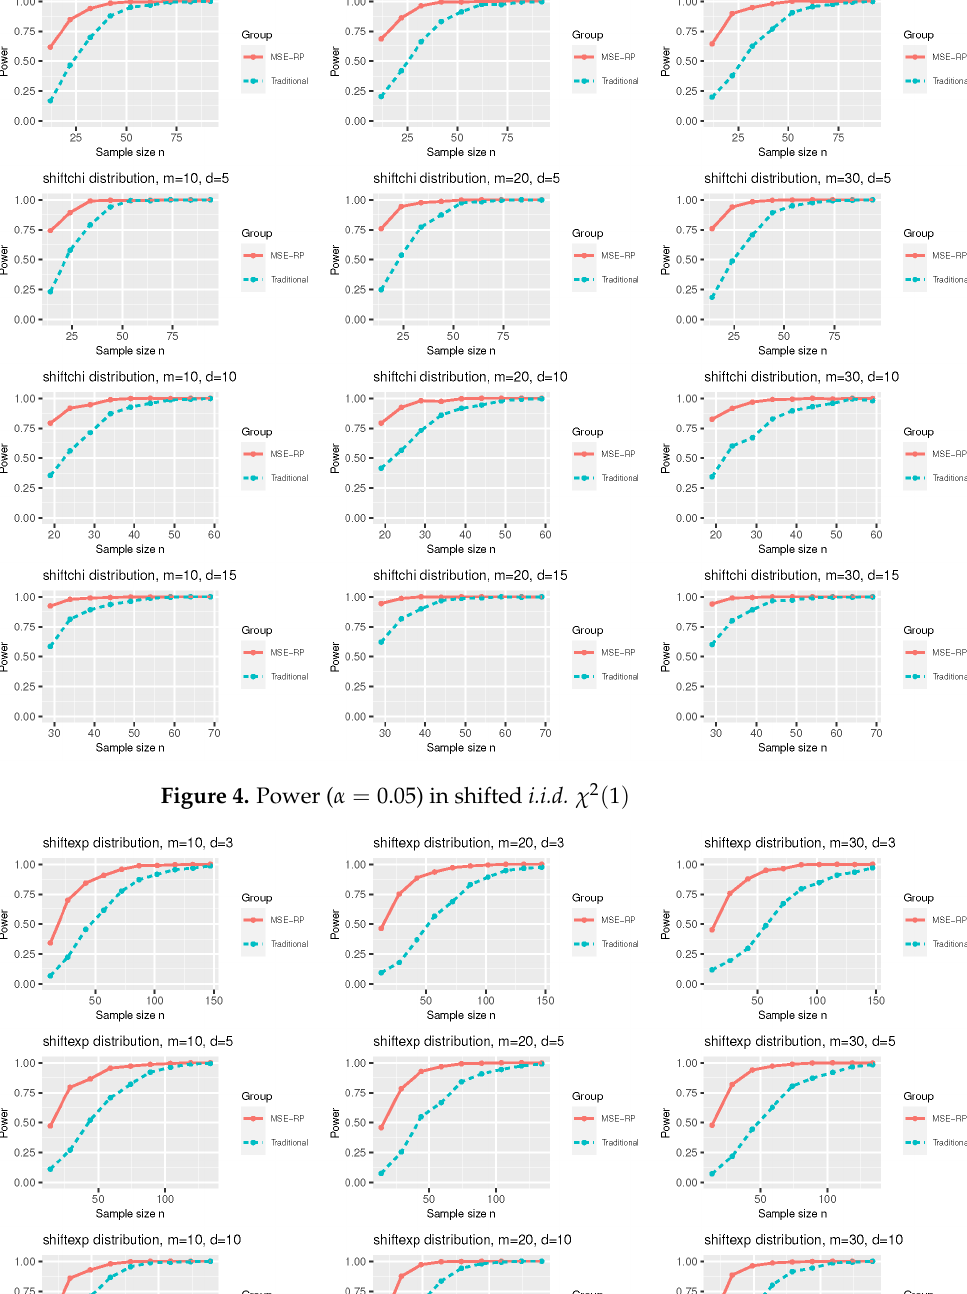
Figure 5. Power ( α = 0.05) in shifted i.i.d. exp ( 1 )